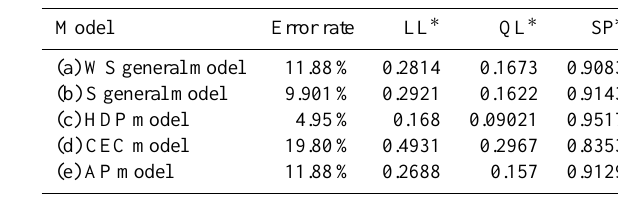
Table 1. Performance and error analysis for WS, S, HDP, CEC and AP